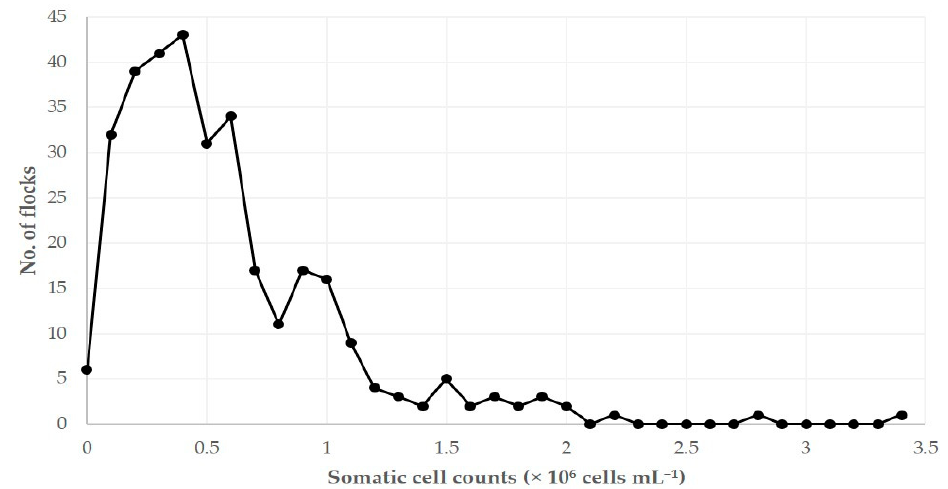
Figure 2. Distribution of 325 sheep flocks in Greece in accord with somatic cell counts in bulk-tank